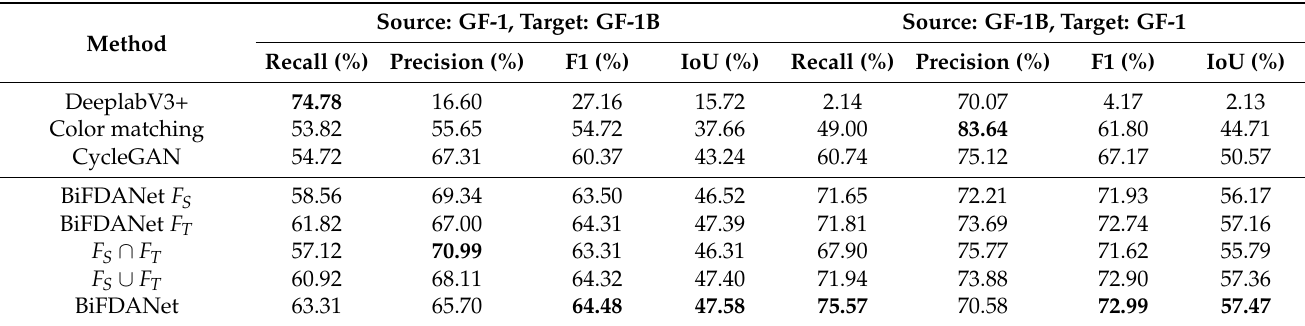
Table 2. Comparison results on Gaofen dataset. The best values are in bold.